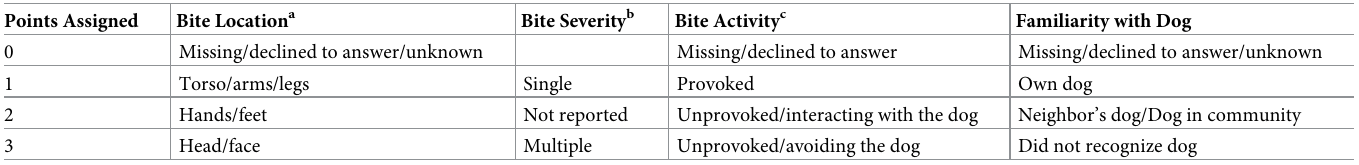
selected based on data available from the KAP survey, disease subject matter expertise, and Bradford Hill Criteria qualification [13]. For not bitten respondents, these variables included age, sex, percent below poverty, district, status of dog ownership, nearest distance to PEP, knowledge score, and wealth score. The effect of the interaction of the wealth and knowledge score variables was assessed but not significant, and therefore was not included in further anal- ysis. For bite victims, these variables included age, sex, percent below poverty, district, owner- ship of the biting dog, nearest distance to PEP, rabies exposure risk score, and wealth score. Of these predictors, community-level variables included percent below poverty and district. Table 3. Construction of rabies exposure risk